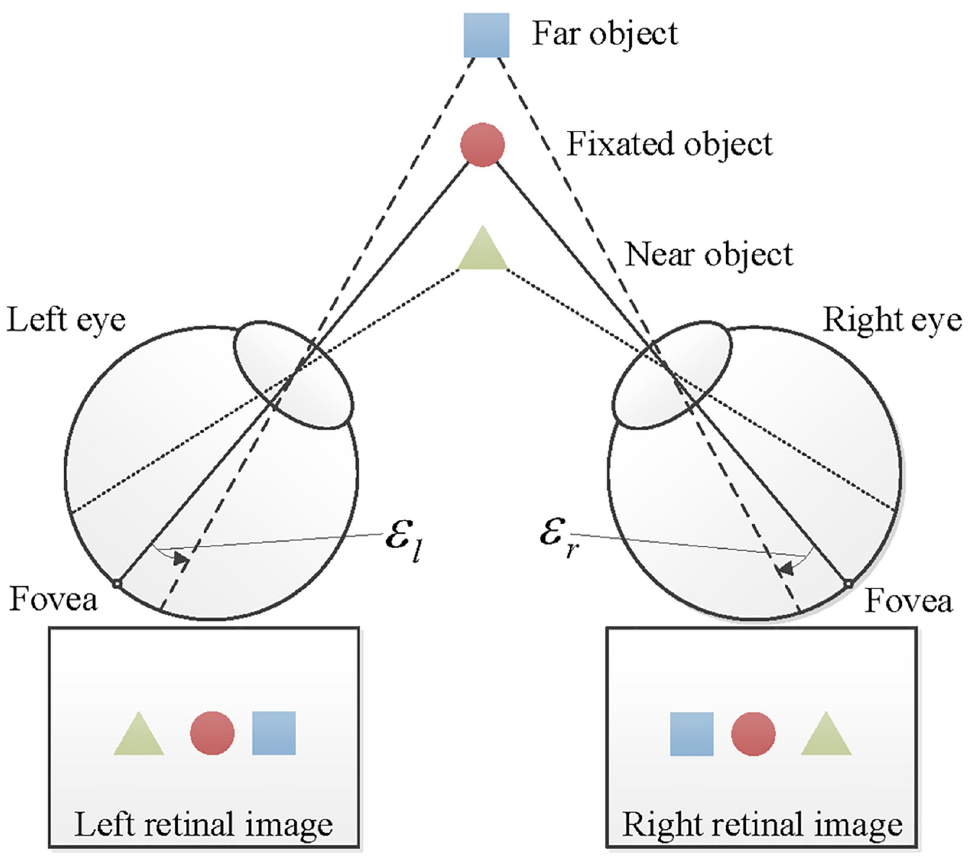
Fig 1. Viewer perspective retinal projection of objects showing different horizontal visual eccentricities ( E ), based on relative distances from the fixated point.